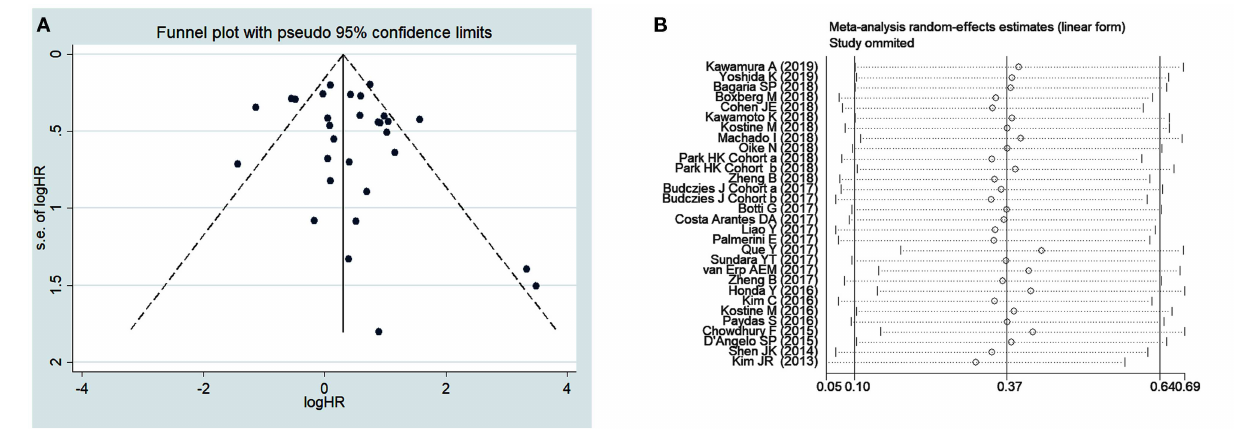
PD-L1 overexpression could predict poor OS, MFS, and